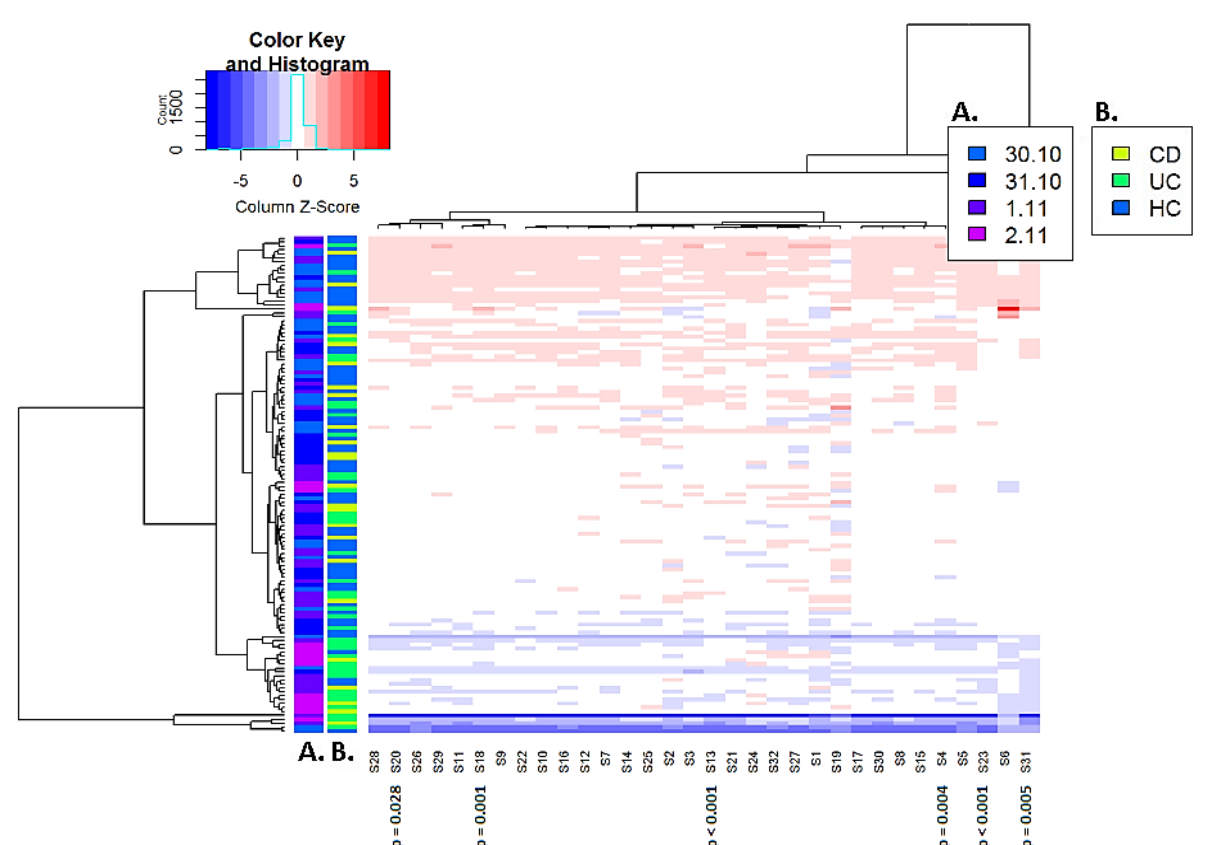
Figure 3. Scaled heatmap of sensor output after correction for date of measurement. Scaled heatmaps of the sensor output. Date of sample measurement was found a confounding factor. Therefore, a correction was applied for date of measurement for all sensor outcomes. Then, the mean and standard deviation per sensor across all samples were calculated. Each sample measurement was subtracted from the mean sensor outcome and divided by its standard deviation. This was across all sensors and samples so that all sensor measurements were on the same scale. Samples are depicted on the Y-axis, while sensors are depicted on the X-axis. Colored strips on the Y-axis depict the distribution of sample characteristics amongst the samples. ( A ) Distribution of measurement date. ( B ) Distribution of CD, UC patients and controls. The six discriminating sensors are indicated by the p -values for the discrimination between IBD and controls.